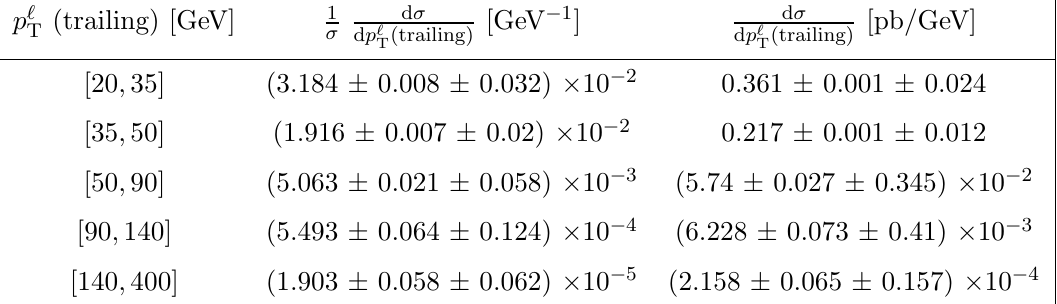
Table 32 . The measured di(cid:11)erential cross section and bin boundaries for each bin of the normalized and absolute measurements of the tt di(cid:11)erential cross section at particle level in the (cid:12)ducial phase space as a function of p ‘ (trailing) are T